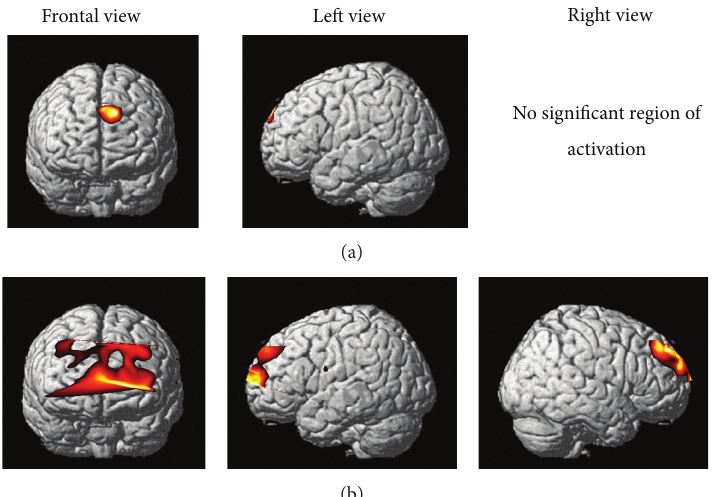
Figure 5: (a) Significant areas of activation comparing the slow internet Δ activation while subjects encountered the computer virus ( 𝑛 = 11 ).